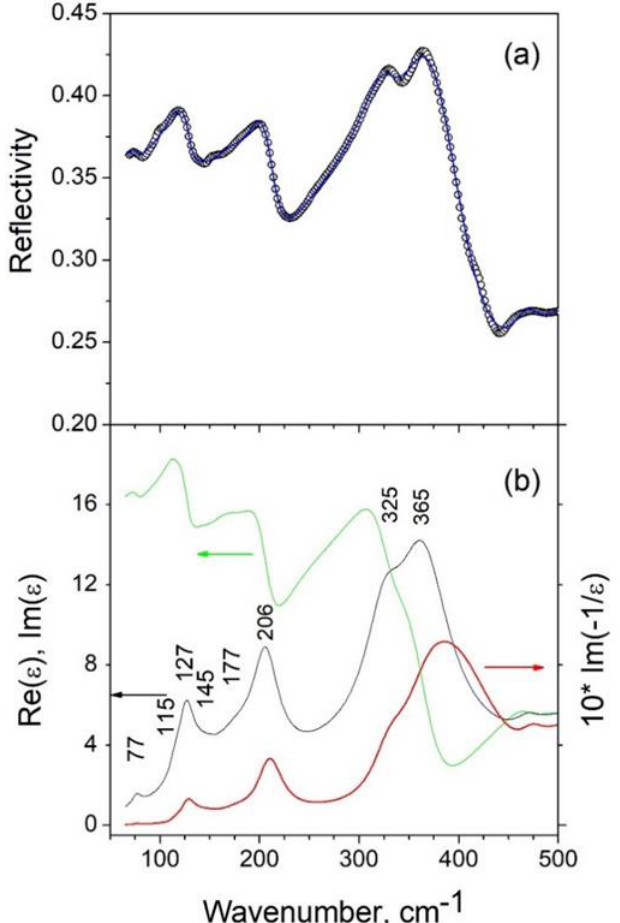
Figure 5. ( a ) Room-temperature experimental (open points) and simulated (blue solid line) IR reflectivity spectra of AgGaGeS 4 . ( b ) Spectral dependence of the real and imaginary parts of the dielectric function (green and black lines, respectively) and the loss function (red line) obtained via modeling of the dielectric function and fitting the reflectance.